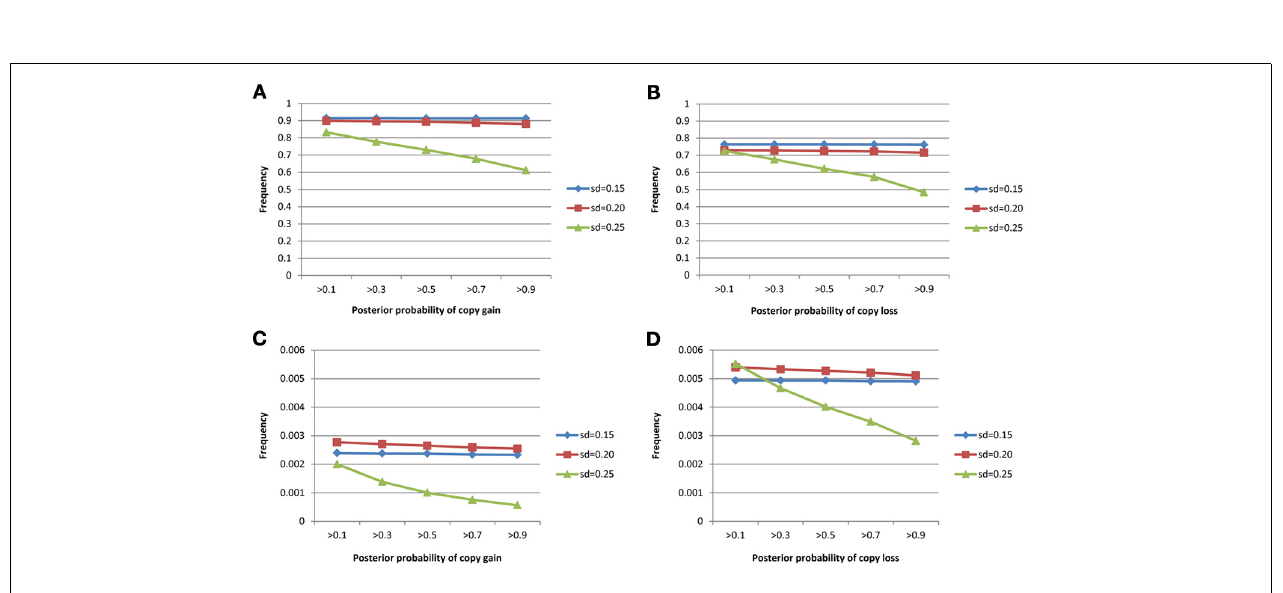
FIGURE 6 | True positive rates of detecting copy gain/loss and false positive rates of detecting copy gain/loss with different cut-points for determination of the de novo mutation. (A) For